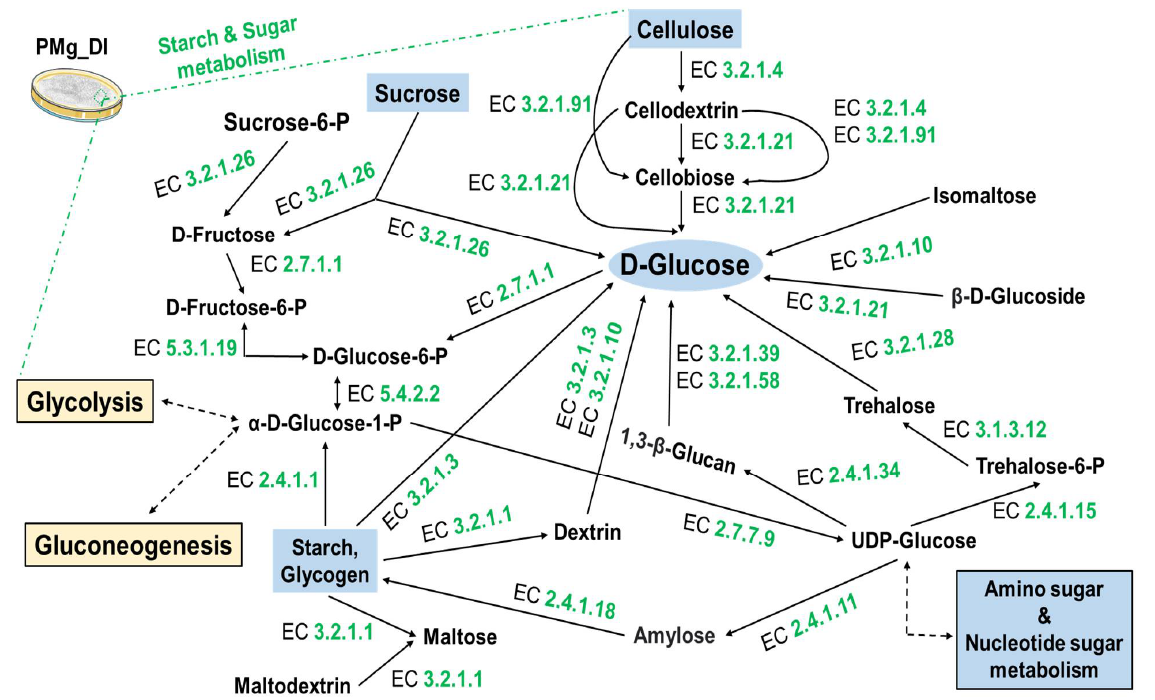
Figure 7. Schematic illustration of starch and sucrose metabolism pathways showing the cellulose polysaccharide breakdown routes and main cell wall degradation enzymes (CWDEs), namely, EC 3.2.1.4, EC 3.2.1.91, and 3.2.1.21. The sysnames of enzymes related to the biosynthetic machinery are depicted in purple-colored EC numbers: EC 3.2.1.4: 4- β -D-glucan 4-glucanohydrolase; EC 3.2.1.21: β -D-glucoside